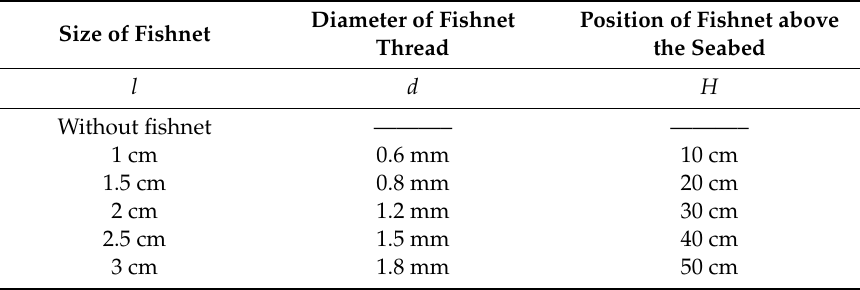
Table 3. Scenarios considered in the laboratory tests.